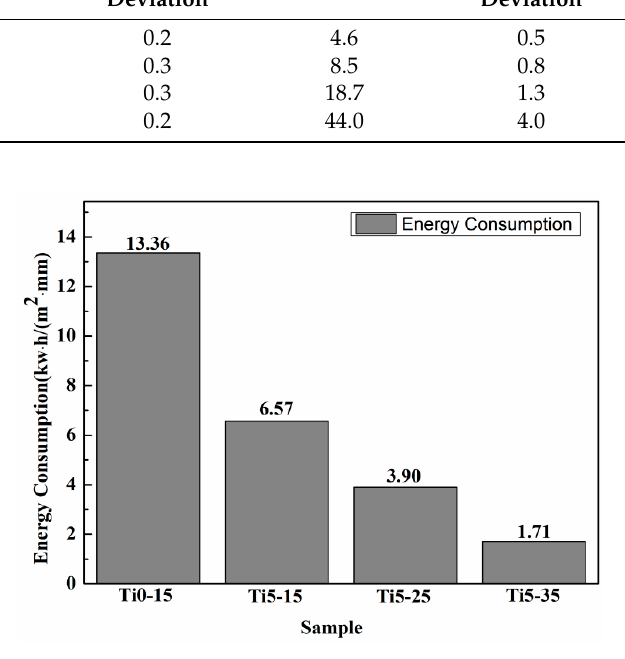
Figure 5. Energy consumption ( ρ ) for 10 min of micro ‐ arc oxidation for different